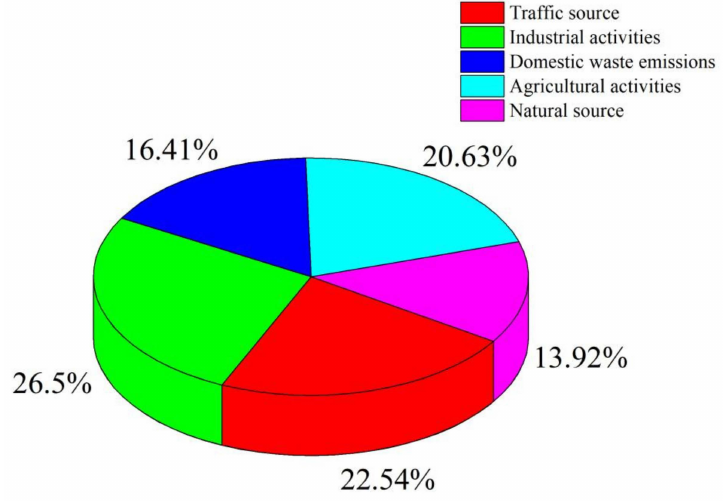
Figure 6. Contribution rate of different sources of heavy